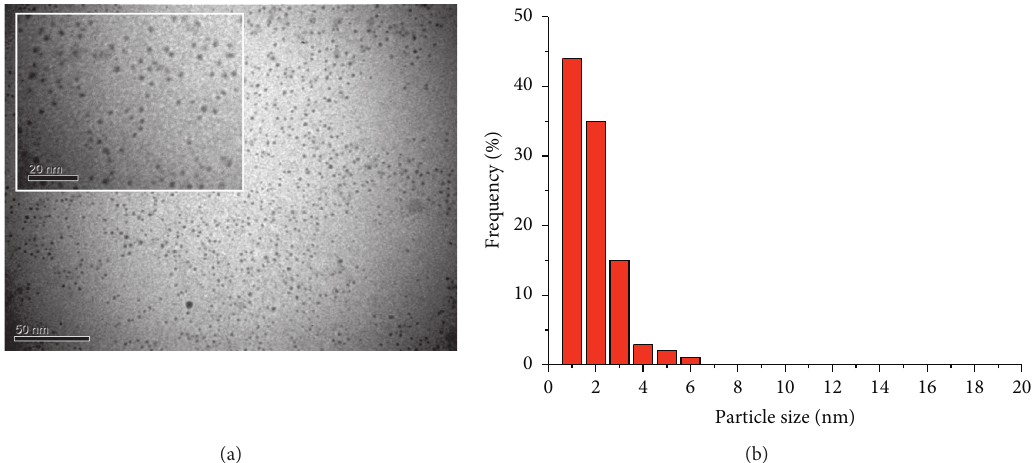
Figure 7: TEM images (a) and the size distribution histograms (b) of AgNPs, synthesized in RL solution (2g/L) at 40 cycles, t � 20 ° C. Reproduced from [42] under the terms of the Creative Commons CC BY